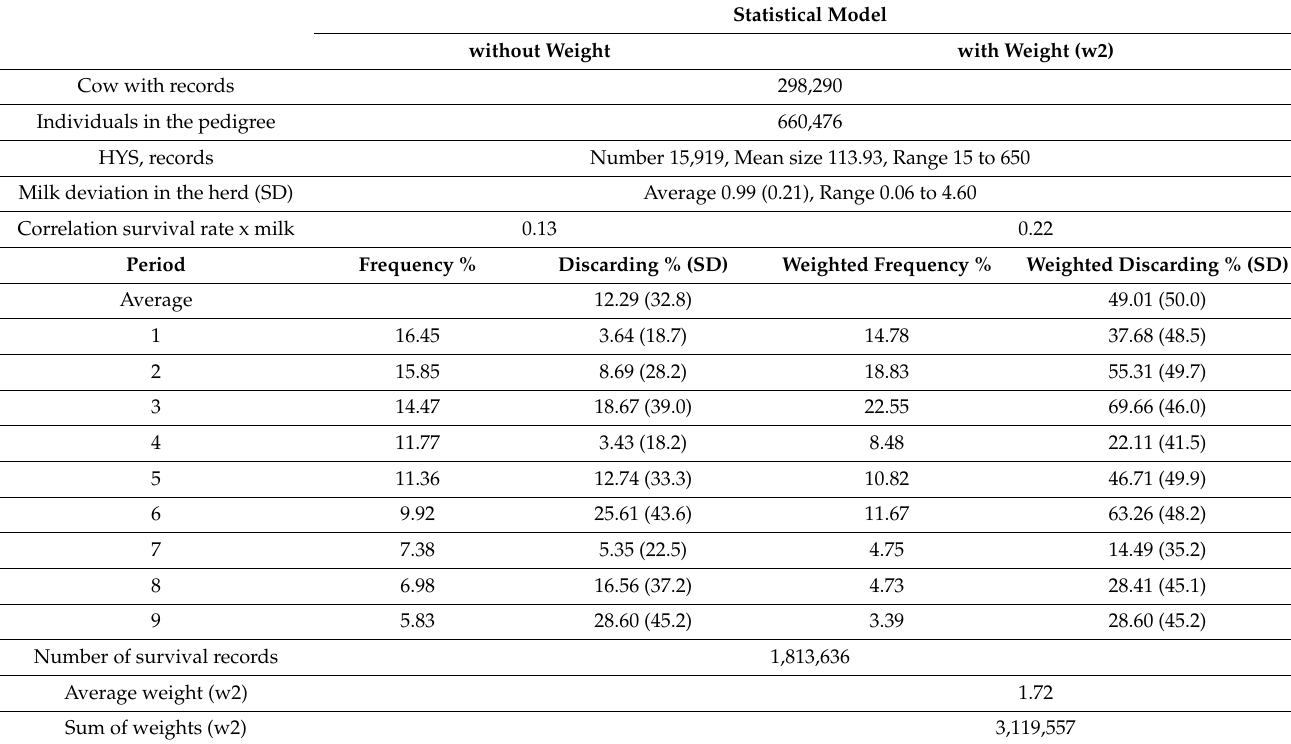
Table 2. Description of edited